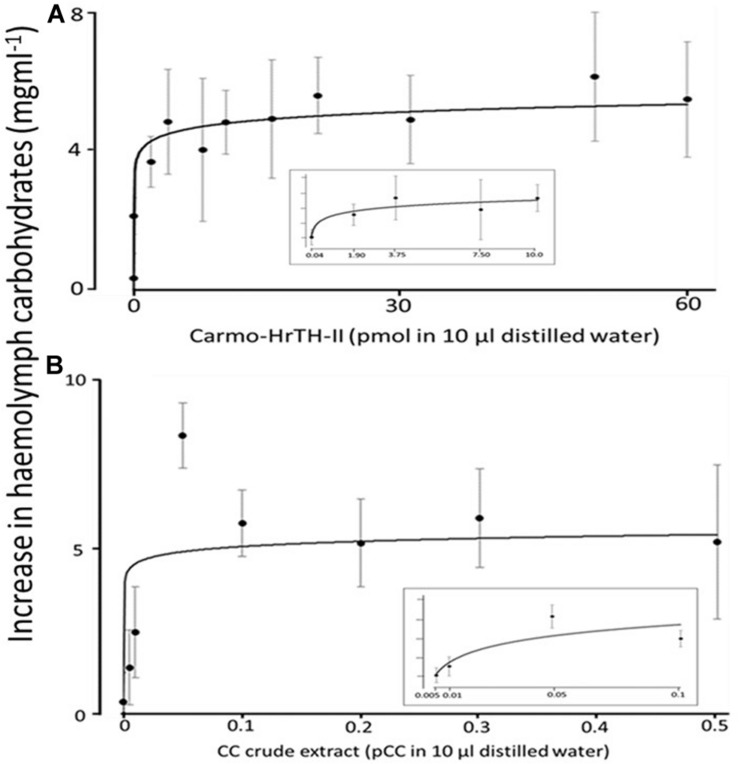
In vivo hypertrehalosemic assays. The effects of the increasing doses of (A) synthetic Carmo-HrTH-II and (B) native CC extracts, on carbohydrate mobilization in ligated 6th instar nymphs of C. morosus (17–18 days old). Each data point represents the mean ± SD in mg ml–1. Between 7 and 12 insects were used for each dose.